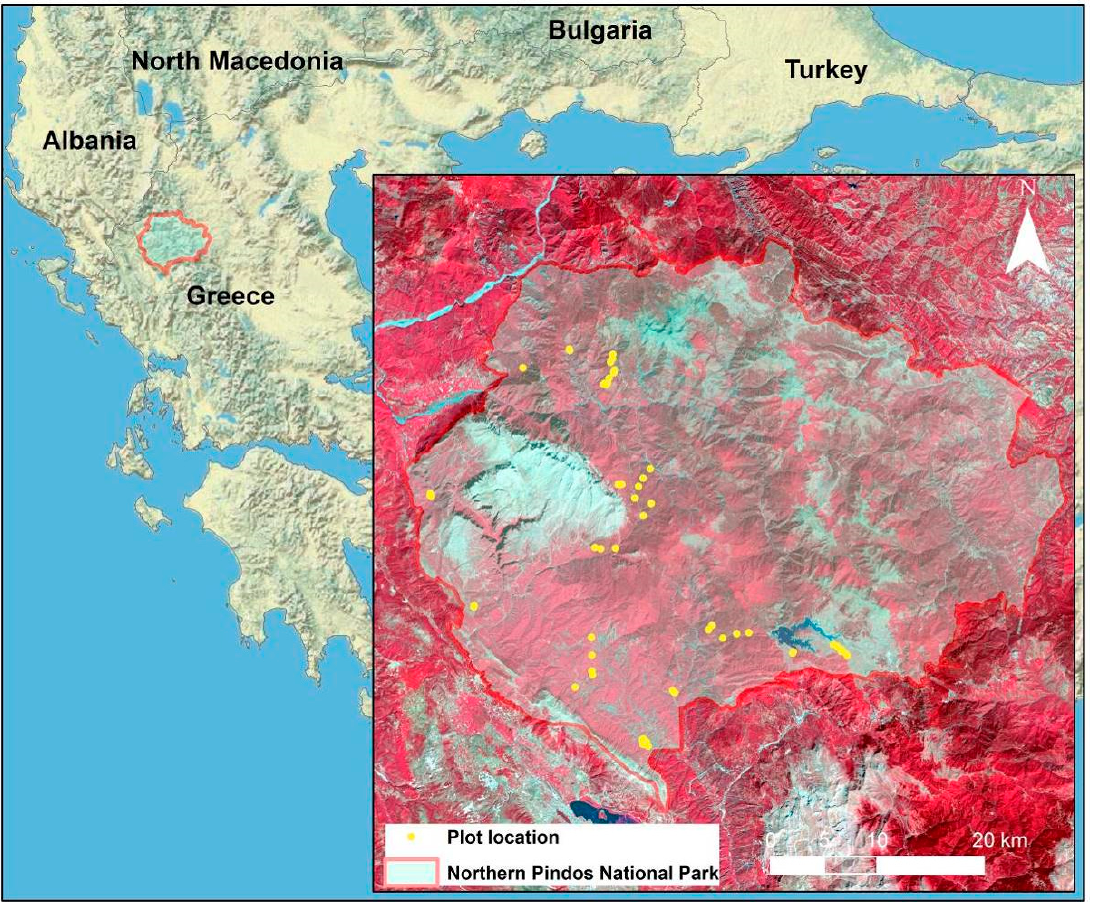
Figure 1. Study area and field plot location overlaid on a Sentinel-2 image (red: near infrared 2; green: red; blue: green).